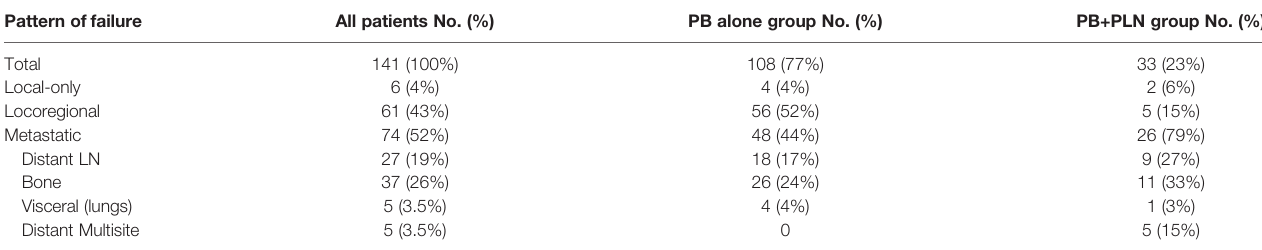
TABLE 3 | Summary of type and sites of failure relative to prior RT fi eld. Pattern of